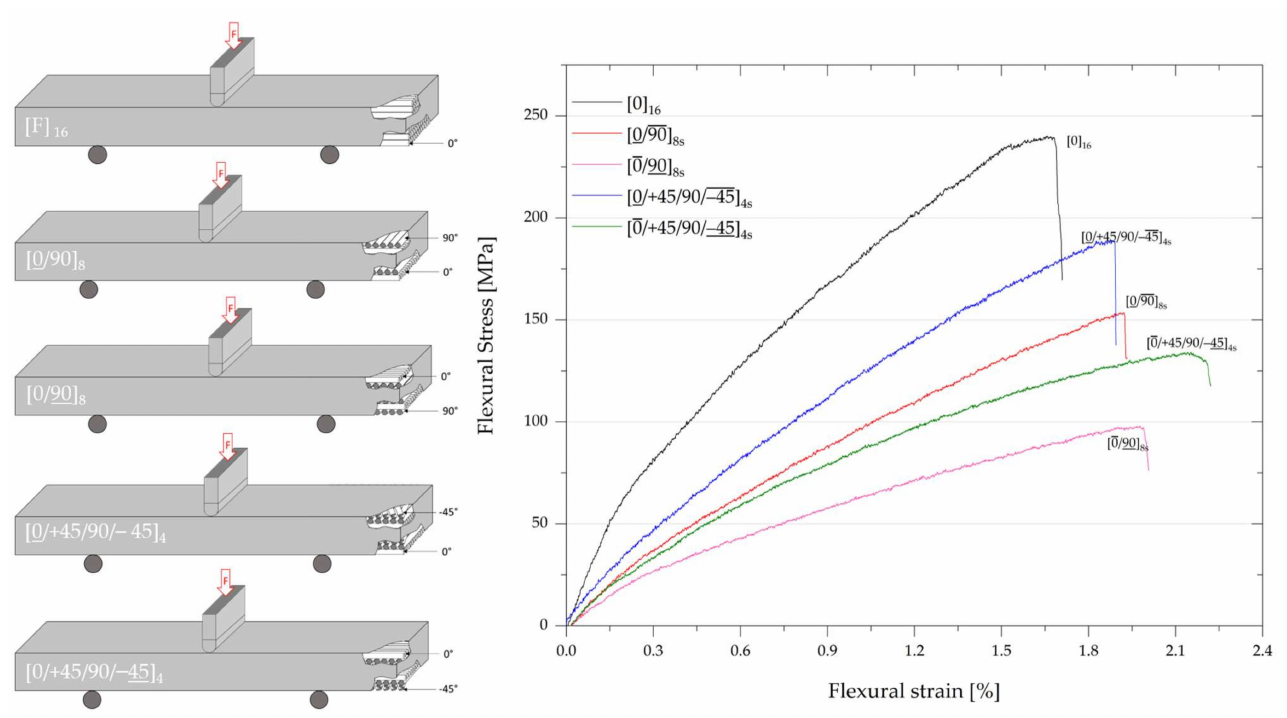
Figure 1. Configuration of flexural laminate samples ( left side ) and stress-strain curves obtained from sample testing ( right side